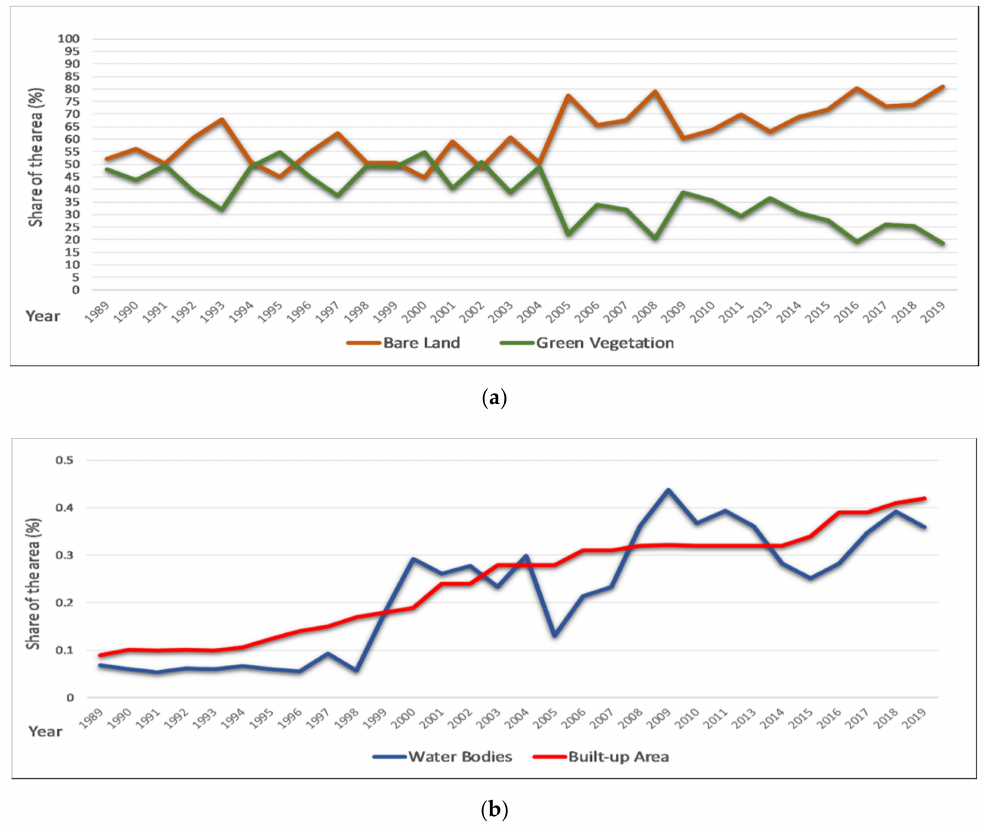
Figure 3. Share of land-cover classes in dry season from Landsat images from 1989 and 2019. ( a ) Bare Land and Green Vegetation, ( b ) Water Bodies and Built-up Area.